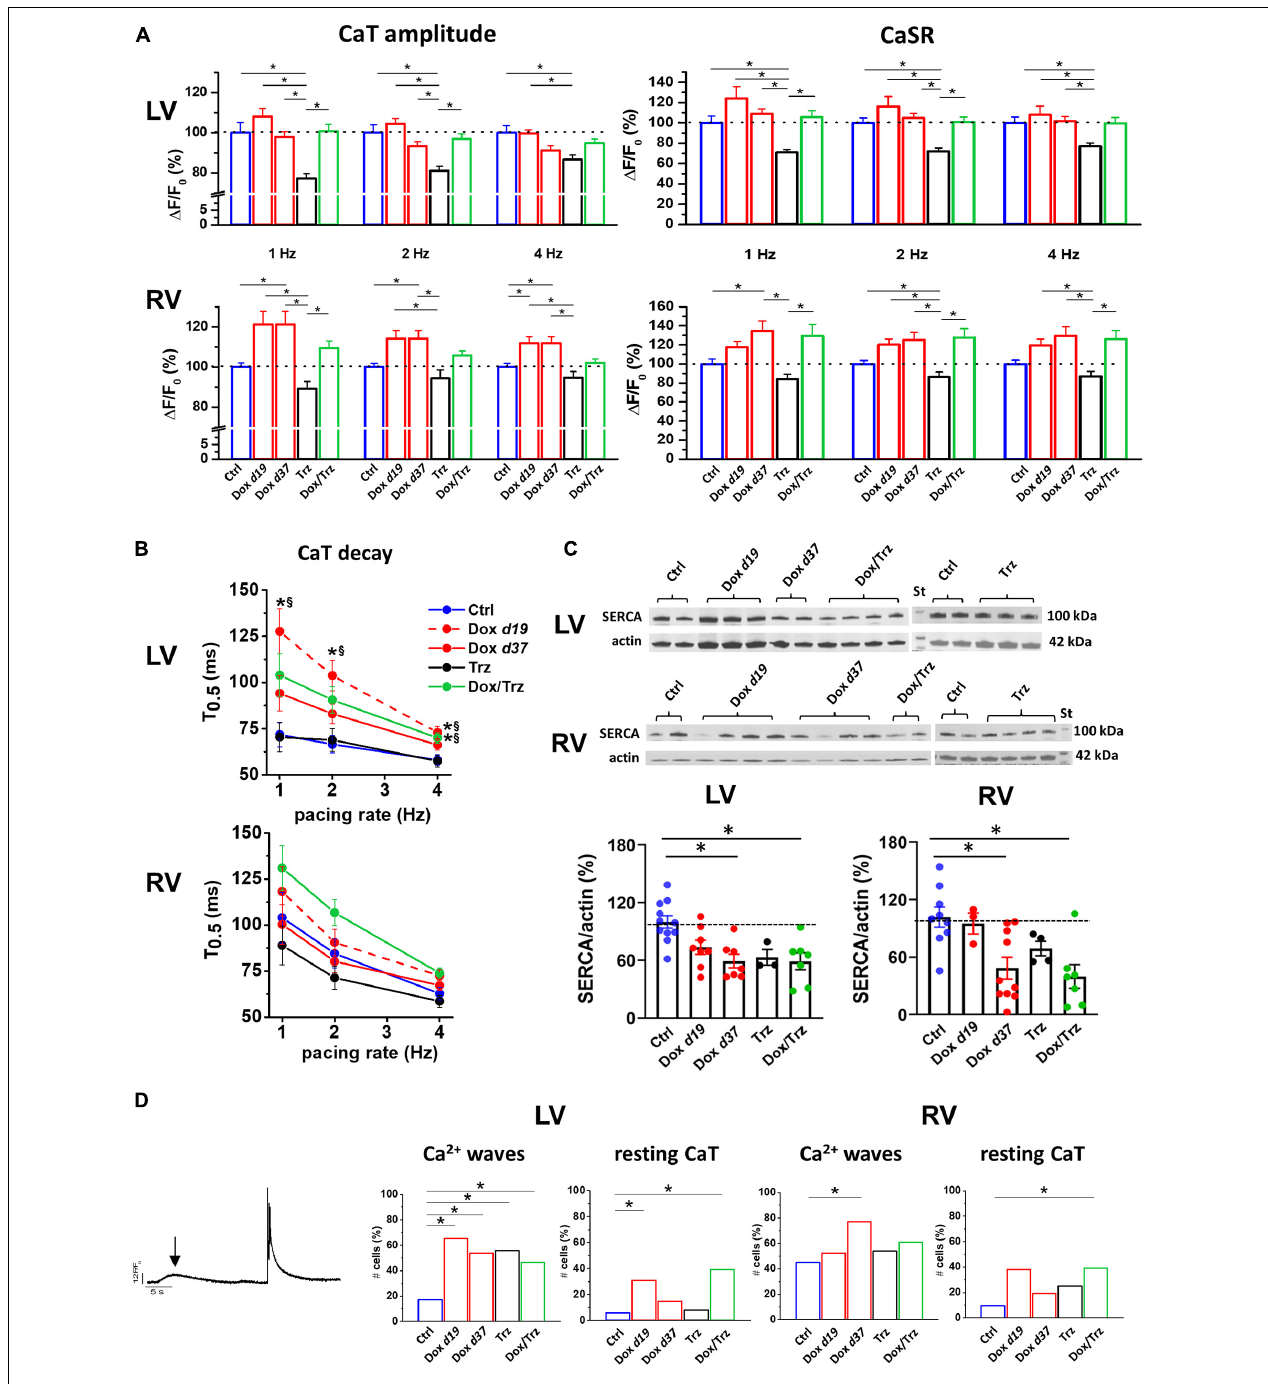
FIGURE 5 | Effects of Dox and Trz on intracellular Ca 2 + handling. (A) Quantitative analysis of Ca 2 + transient (CaT) amplitude and SR Ca 2 + content (CaSR) estimated by a caffeine pulse at different pacing rates (1, 2, and 4 Hz) in field stimulated LV and RV CMs. Dox increased both CaT amplitude and CaSR in RV CMs but not in LV CMs, whereas Trz reduced them in both CMs. (B) Rate dependency of CaT decay kinetics (CaT decay half time, T 0 . 5 ) in both RV and LV CMs. LV CaT decay was slower in the Dox and Dox/Trz groups, but not in the Trz group, compared to Ctrl. * p < 0.05 vs. Ctrl, § p < 0.05 vs. Trz. (C) Immunoblots showing SERCA protein levels ( n = 2–4 rats/group; data in the Trz group and respective Ctrl were analyzed separately). Densitometric analysis. (D) Left panel: Example of Ca 2 + wave (arrow) and spontaneous CaT occurring at resting. Quantitative analysis of cells (%) exhibiting spontaneous Ca 2 + waves and resting CaT in both LV and RV CMs. Data on the Dox group are shown at d19 and at d37. One-way ANOVA was used to test for significant differences among multiple groups in panel (A,C) . Mixed effect model of two-way ANOVA was used in panel (B) for statistical evaluation of CaT decay of multiple groups vs. pacing rate. Chi 2 -test was used for comparison of categorical variables in panel (D) . Bars are mean ± SEM ( n > 17 cells/group; * p < 0.05).